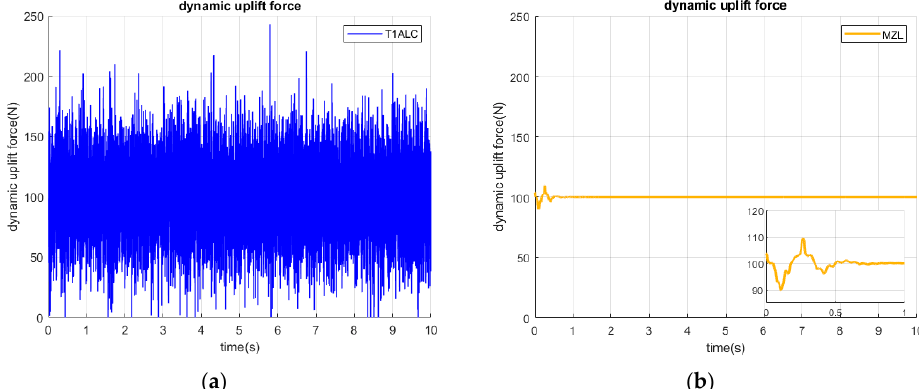
Figure 7. The dynamic uplift force. ( a ) The dynamic uplift force for T1AFLC. ( b ) The dynamic uplift force for proposed IT2AFLC.